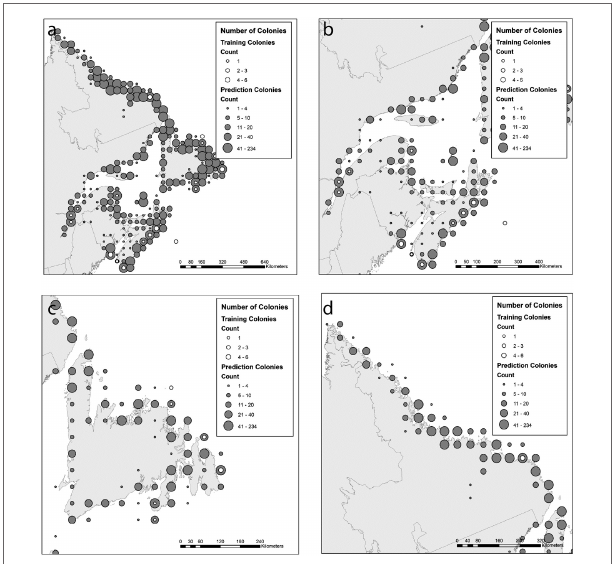
FIGURE 1 | Distribution of colonies from which birds were tracked (hollow circles, “training colonies”) as well as the colonies for which model predictions were applied (solid circles). Model predictions were applied to individual colonies, but colonies are shown here for visualization purposes as numbers of colonies (counts) binned across the landscape. A region-wide view is shown (A) , as well as finer scale maps of the Scotian Shelf/Bay of Fundy/Gulf of St. Lawrence (B) , island of Newfoundland (C) , and Labrador (D)